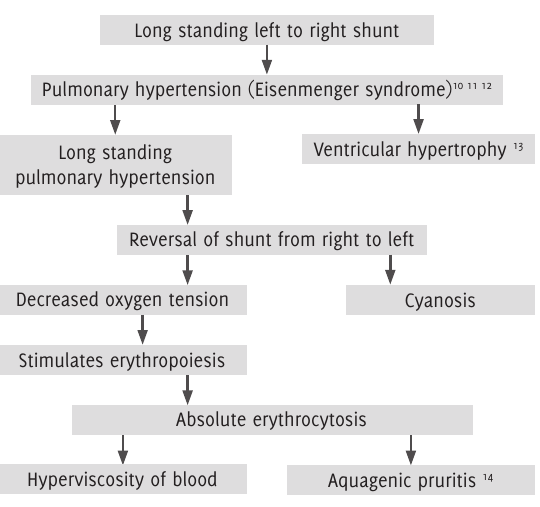
Figure 3. Sequelae of double inlet left ventricle.